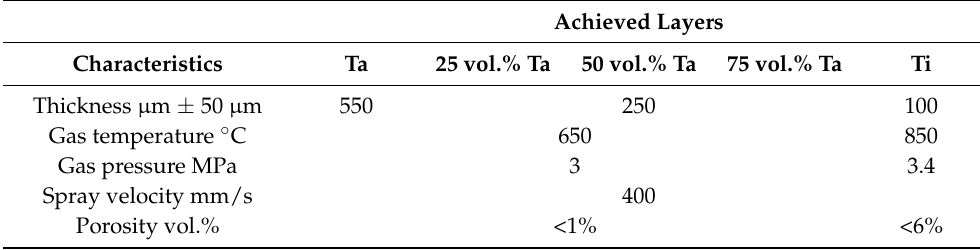
Table 5. Coating manufacturing conditions and characteristics.